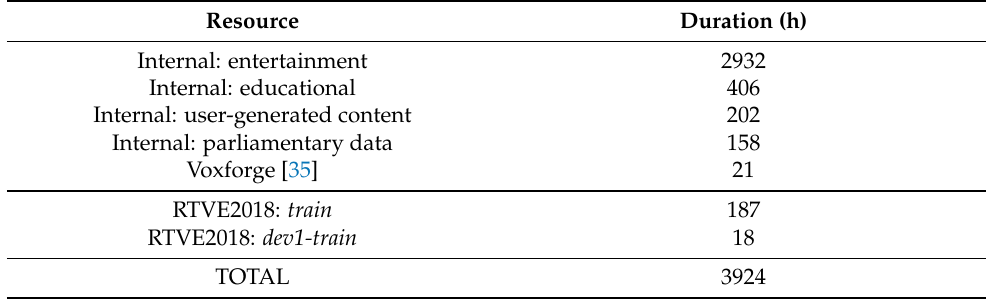
Table 1. Transcribed Spanish speech resources for AM training.